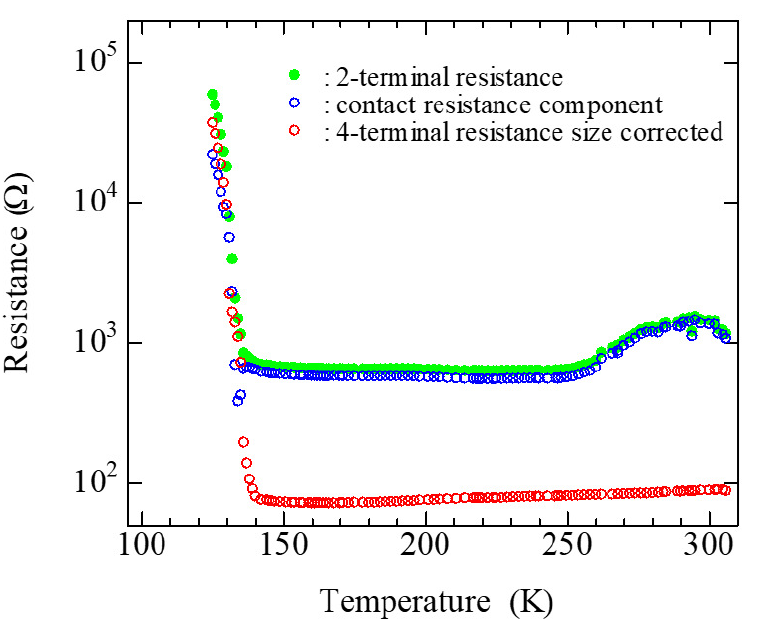
Figure 4. Temperature dependences of the two-terminal resistance, the four-terminal resistance after the channel length correction, and the contact resistance observed in α -(BEDT-TTF) 2 I 3 with the NAC. The contact resistance was extracted by subtracting the four-terminal resistance from the two-terminal